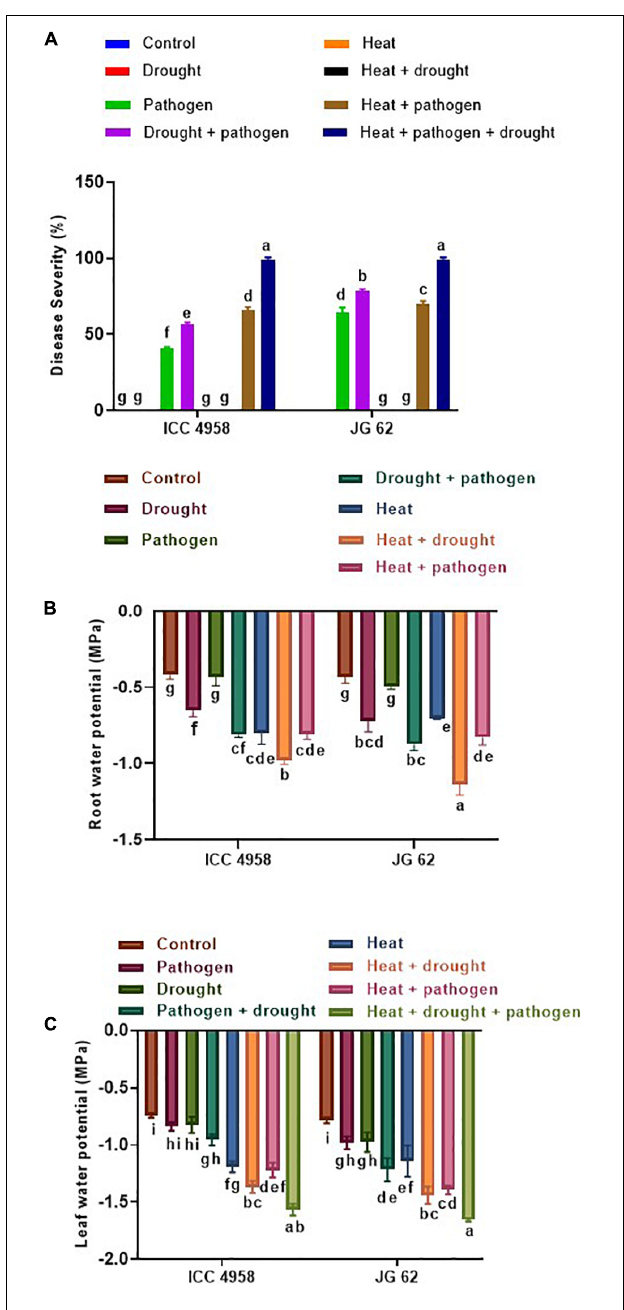
FIGURE 5 | Effect of drought and heat stress on DRR disease severity in ICC 4958 and JG 62 chickpea genotypes. (A) Disease severity in the two genotypes under different stress treatments, namely control, drought, pathogen, drought + pathogen, heat, heat + drought, heat + pathogen, heat + drought + pathogen. (B) Root water potential (C) Leaf water potential of the individual and combined stressed ICC 4958 and JG 62 as measured on the 30th day post-drought imposition ( Supplementary Figure 15 ). Root and leaf water potential were measured using Wiscor Psyprometer in 3 biological replicates per treatment. One replicate constituted three pots per set with each pot having two plants. Error bar signifies the SEM. Statistical significance difference between means is checked by one-way ANOVA and Tukey’s Posthoc test. The different letters denote a significant difference between mean at p <